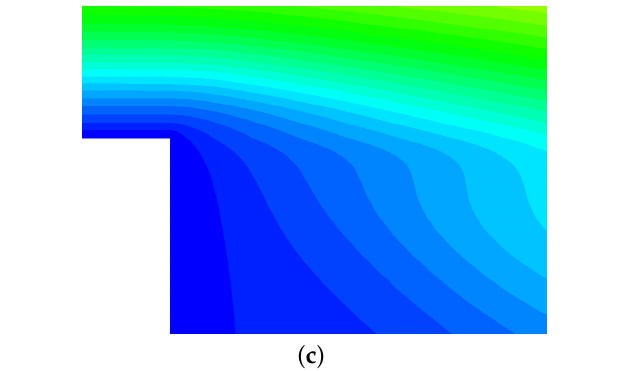
Figure 15. Mean flow contours for a 2D backward-facing step using the new block interface treatment. Note that the normalised turbulent viscosity ( ν t / ν ∞ ) varies smoothly across the block-interfaces, which are transparent to the flow. ( a ) Contours of mean velocity magnitude ( U / U ∞ ); ( b ) Contours mean normalised turbulent kinematic viscosity ( ν t / ν ∞ ); ( c ) Zoomed-in view of Figure 15b at the block interface.